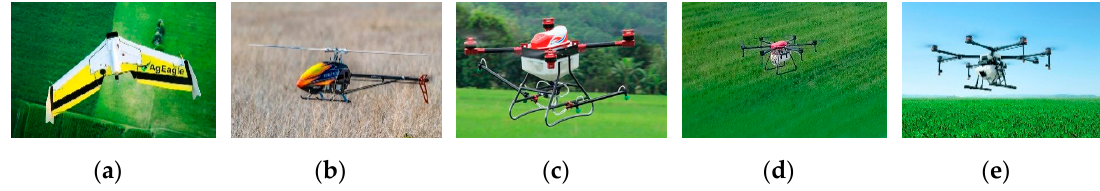
Figure 1. RPAS (remotely piloted aircraft system) types: Fixed-wing ( a ). Single-rotor ( b ). Quad Copter ( c ). Hexa Copter ( d ). Octo Copter ( e ).